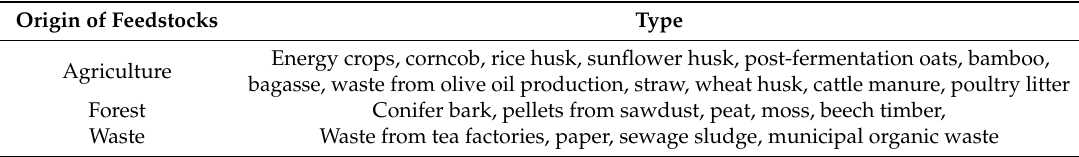
Table 1. Selected feedstocks used in biochar production [25–30].